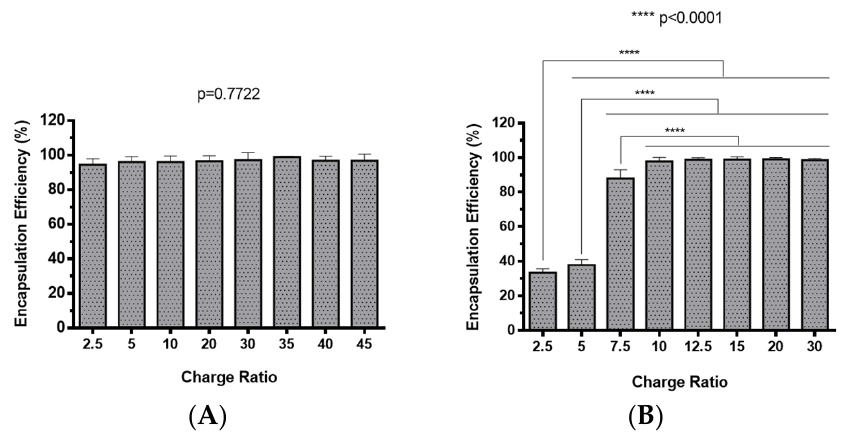
Figure 2. Encapsulation efficiency of different pre-miR-29b-loaded polyplexes at various N/P ratios: ( A ) CS-SA/pre-miR-29b polyplexes and ( B ) PEI-SA/pre-miR-29b polyplexes.